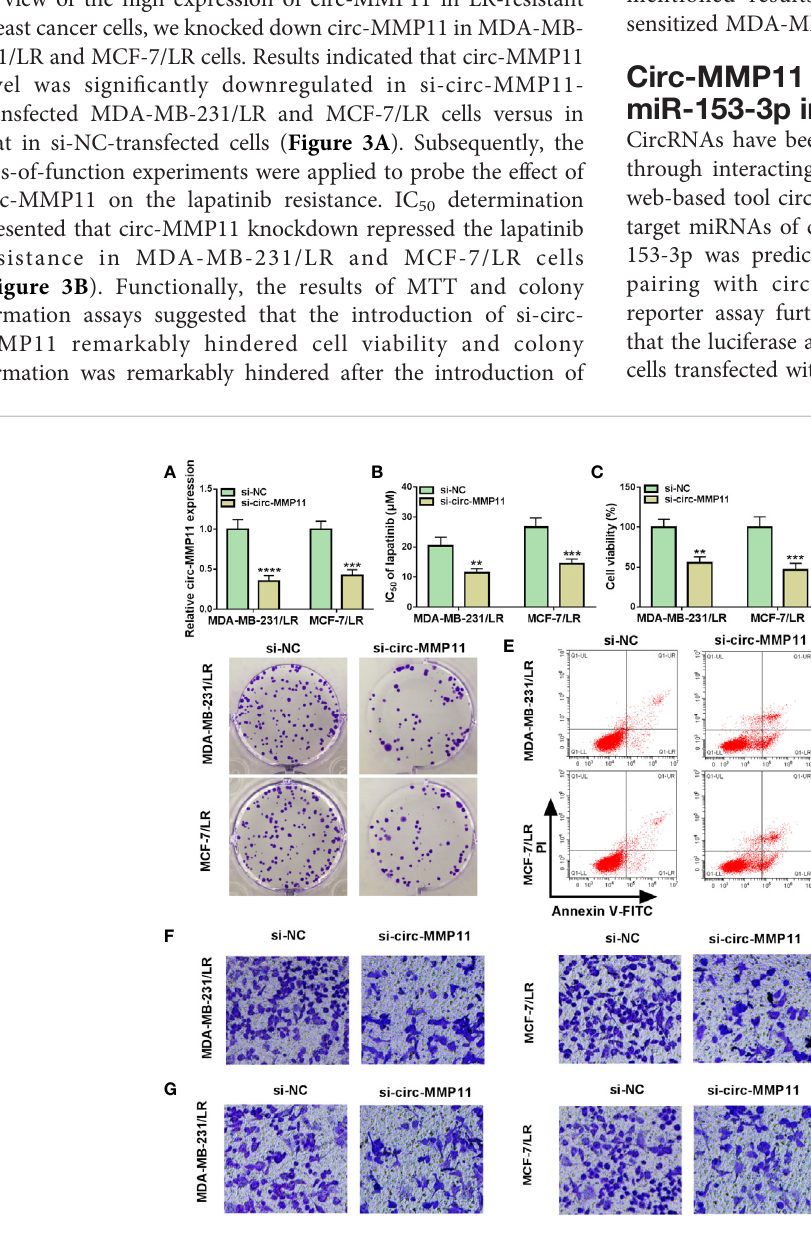
FIGURE 3 | Circ-MMP11 knockdown decreased lapatinib resistance in LR breast cancer cells. MDA-MB-231/LR and MCF-7/LR cells were transfected with si-NC and si-circ-MMP11 . (A) Expression level of circ-MMP11 was detected in transfected MDA-MB-231/LR and MCF-7/LR cells. (B) IC 50 value of lapatinib was detected in transfected MDA-MB-231/LR and MCF-7/LR cells using MTT assay. (C) Cell viability was analyzed in transfected MDA-MB-231/LR and MCF-7/LR cells by MTT assay. (D) Number of colonies was detected in transfected MDA-MB-231/LR and MCF-7/LR cells by cell colony formation assay. (E) Apoptosis rates were assessed in transfected MDA-MB-231/LR and MCF-7/LR cells by fl ow cytometry assay. (F, G) Capacities of migration and invasion were examined in transfected MDA-MB- 231/LR and MCF-7/LR cells by transwell assay. ** P < 0.01, *** P < 0.001, **** P < 0.0001 (ANOVA with Tukey ’ s tests), circ-MMP11 relative to